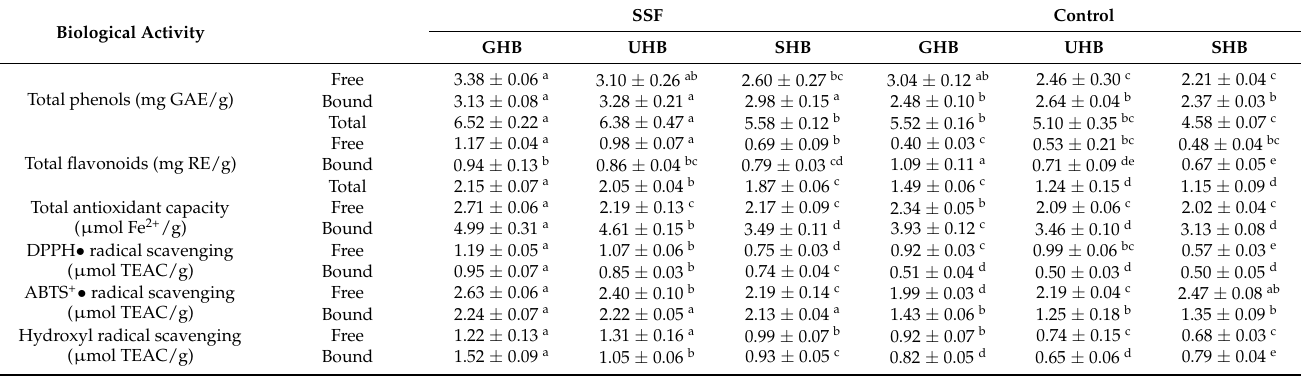
Table 3. Total phenols, total flavonoids and antioxidant activity of the highland barley (the control groups and colonized groups with the mycelia of A. sinodeliciosus var. Chaidam